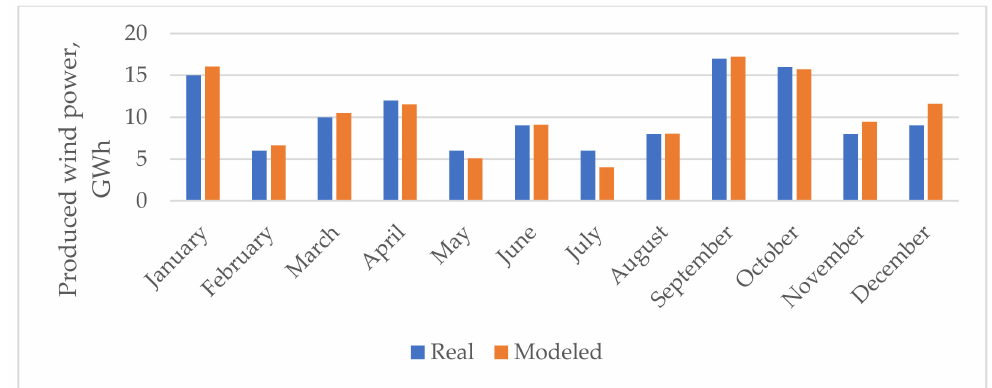
Figure 8. Validation of wind power production rates.